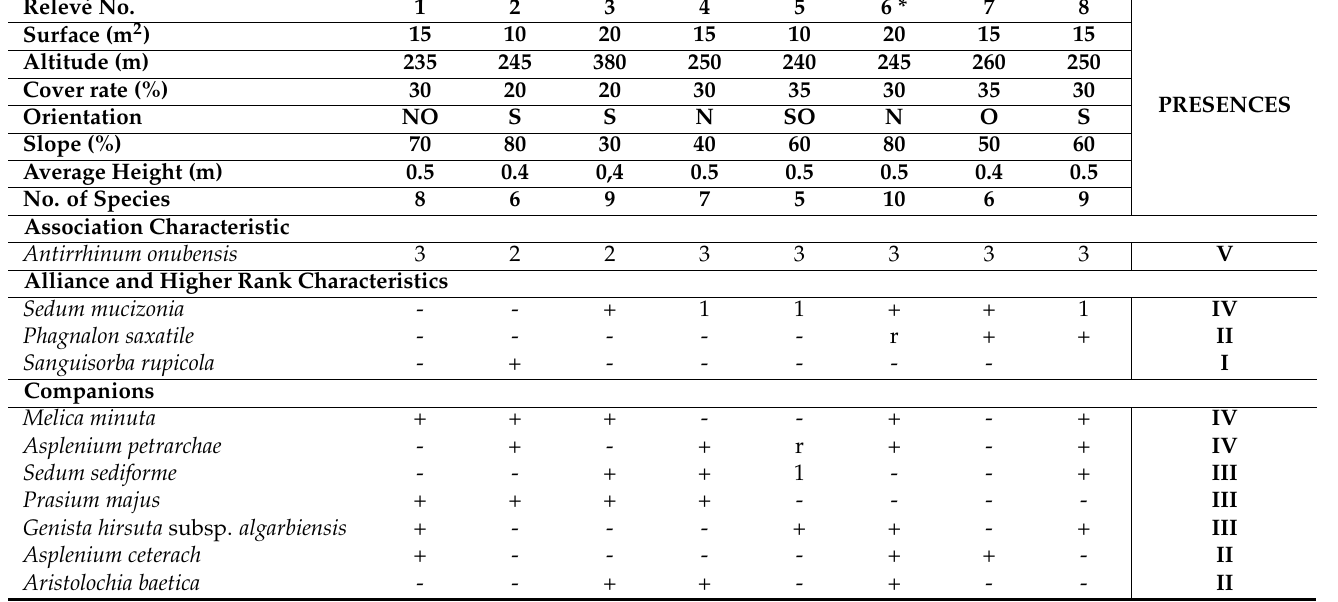
Table 3. Antirrhinetum onubensis ass. nova hoc. loco (Calendulo lusitanicae-Antirrhinion linkiani, Phagnalo saxatilis- Rumicetalia indurati and Phagnalo saxatilis-Rumicetea indurati). Relev é